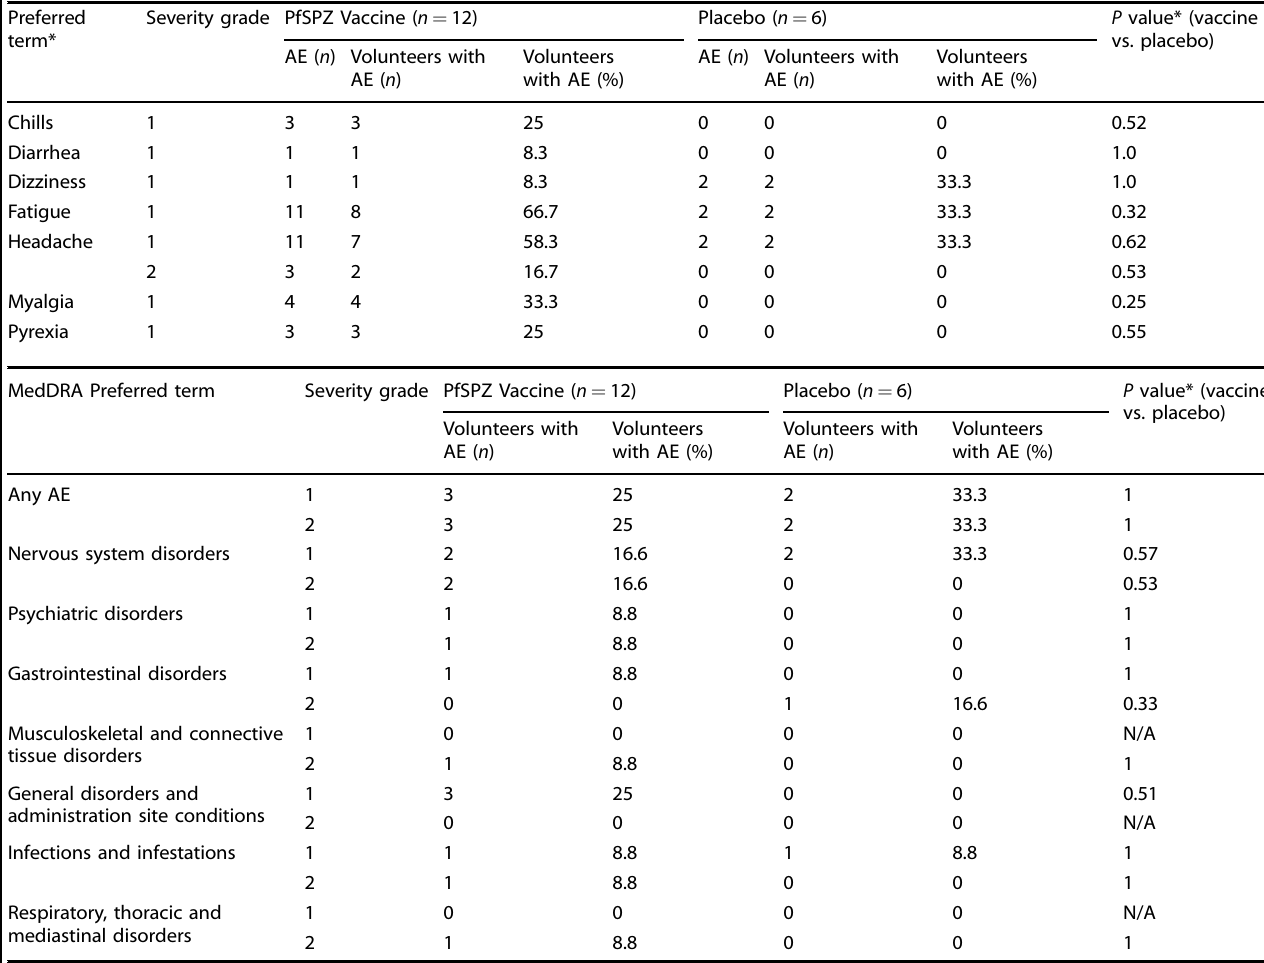
Table 2. a Solicited adverse events during immunization during Veri fi cation . b Unsolicited adverse events during immunization considered to be related to immunization during Veri fi cation